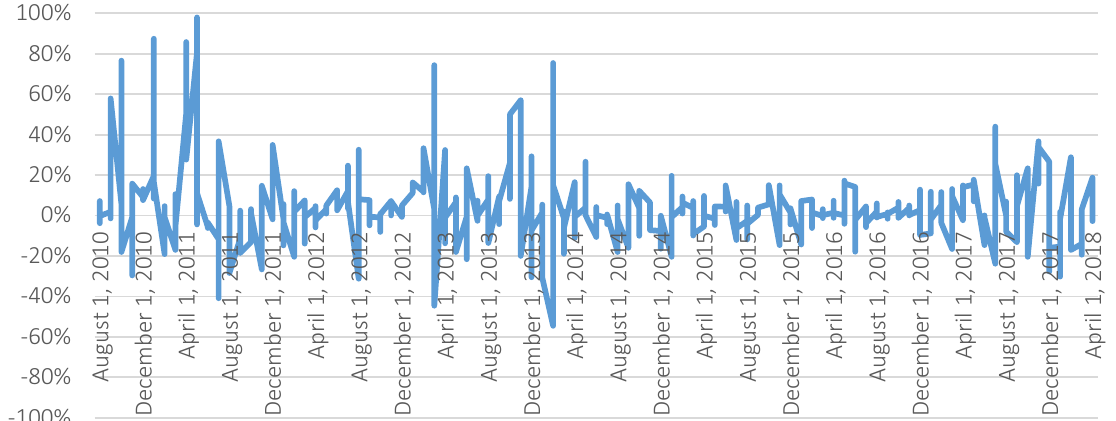
Figure 2. Weekly returns for Bitcoin for the